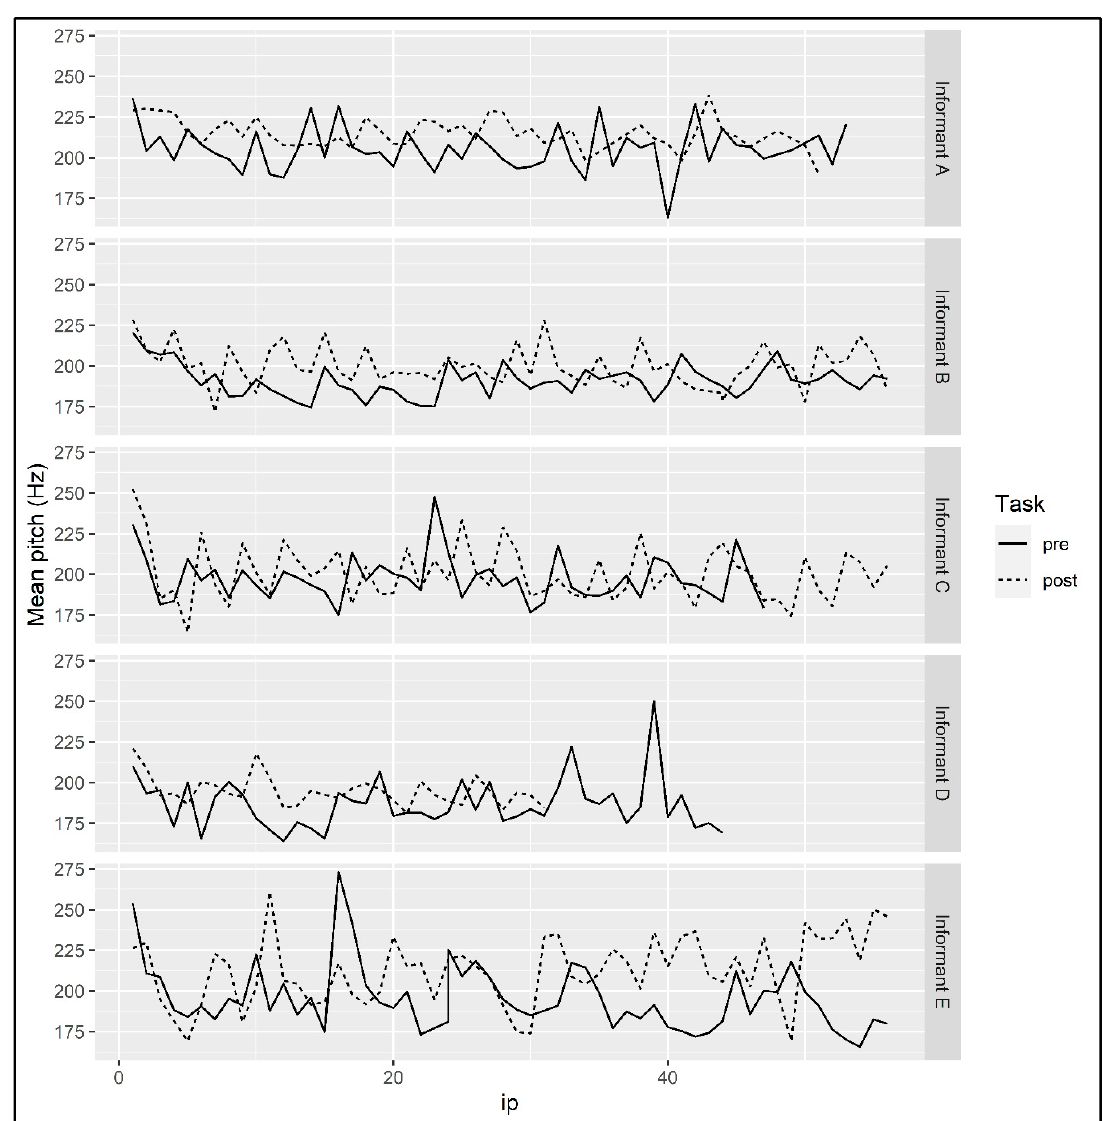
Figure 13. Mean pitch over the course of the narrative for each informant.